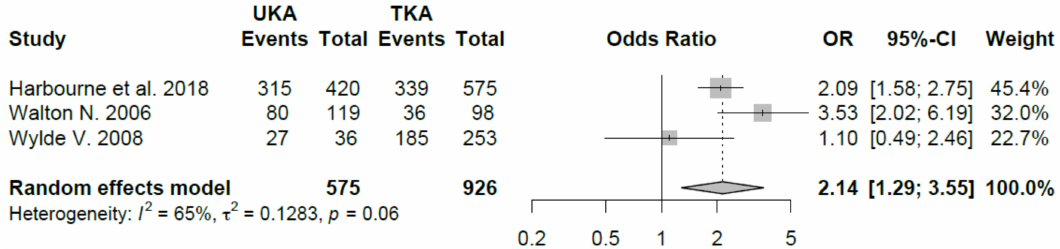
Figure 9. Return to sport after UKA vs. TKA (C.I.: Confidence Intervals, O.R.: Odds